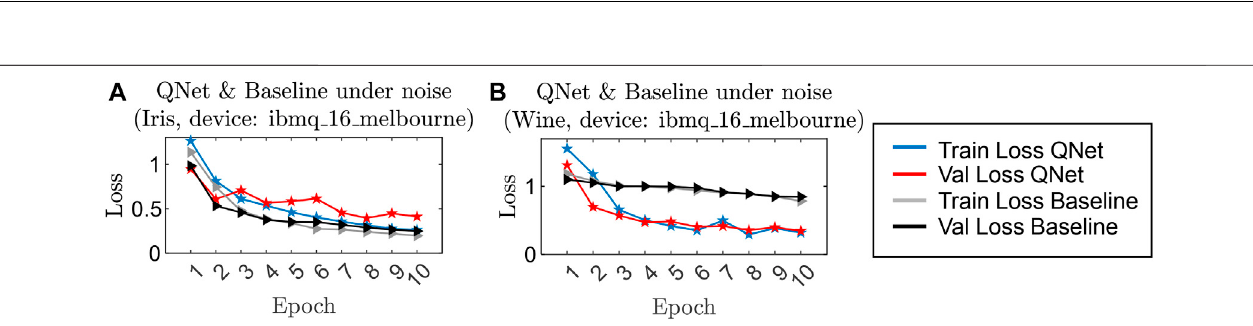
FIGURE 7 | QNet and Baseline model performances in 10 training epochs on a quantum hardware emulator (simulated ibmq_16_melbourne) with similar network sizes (same number of trainable circuit parameters). (A,B) shows the performances on Iris and Wine datasets, respectively. On the smaller Iris dataset (4-features), the performance is comparable. However, on the larger Wine dataset (13-features), QNet shows signi fi cantly better performance under noise.